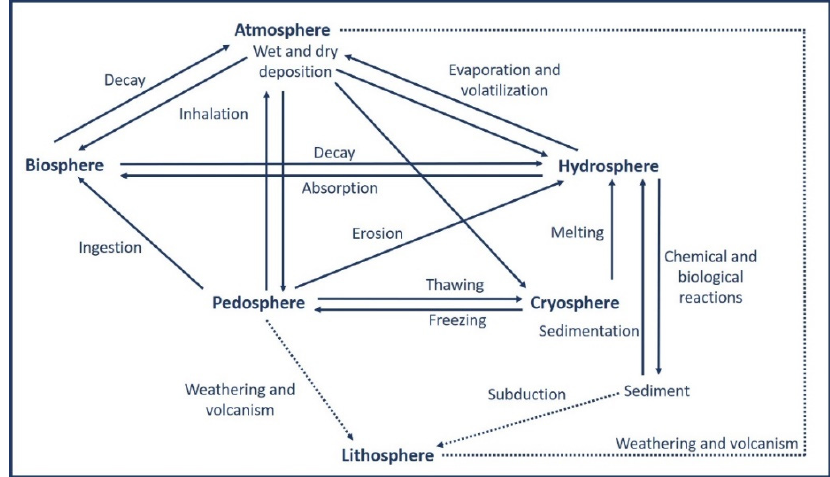
Figure 1. General biogeochemical metal and metalloid cycling throughout environmental and biological compartments (Adapted from [30]).